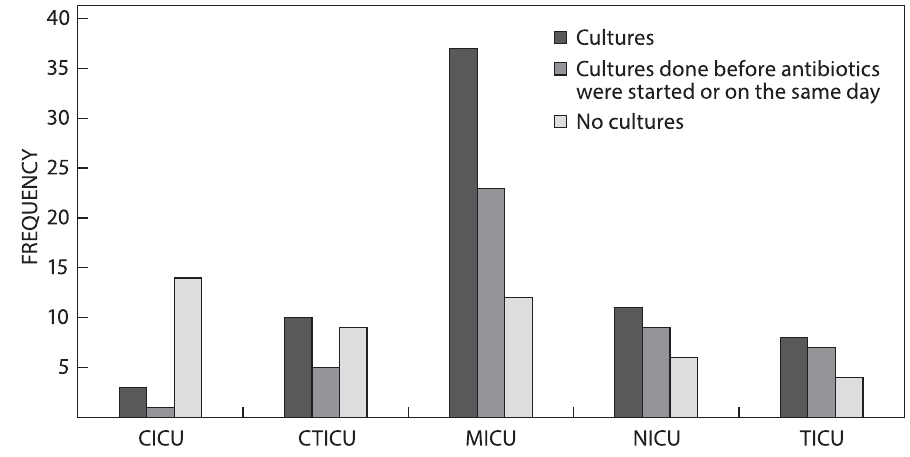
Figure 2: Number of patients on antibiotics who had cultures performed as per ICU.